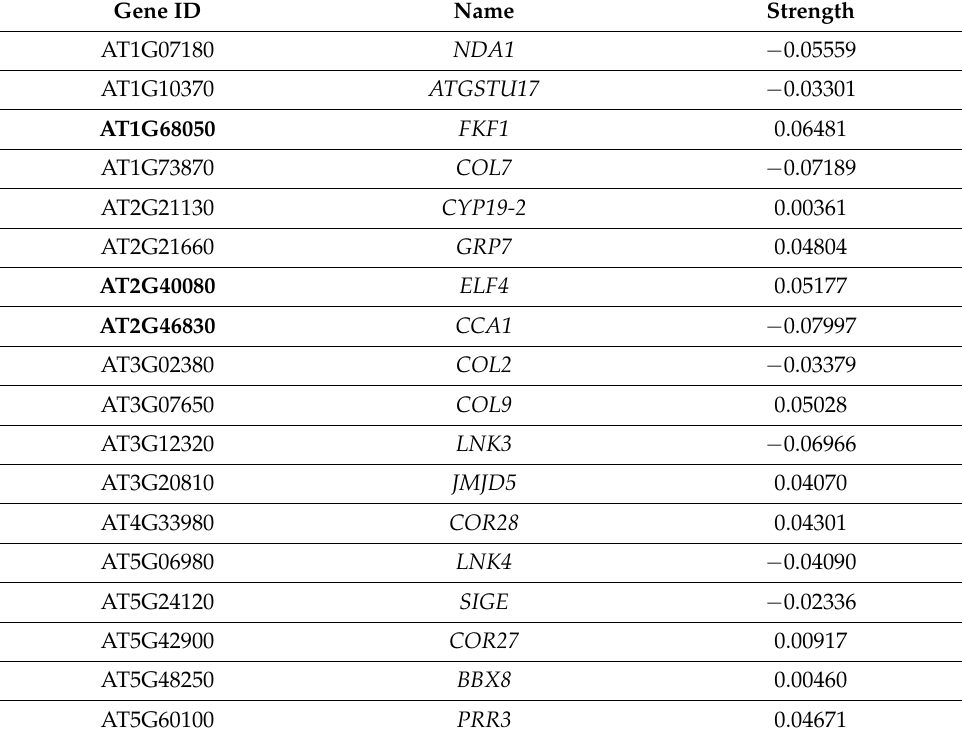
Table 4. Predicted interactions of LNK 2 gene using a fused graphical